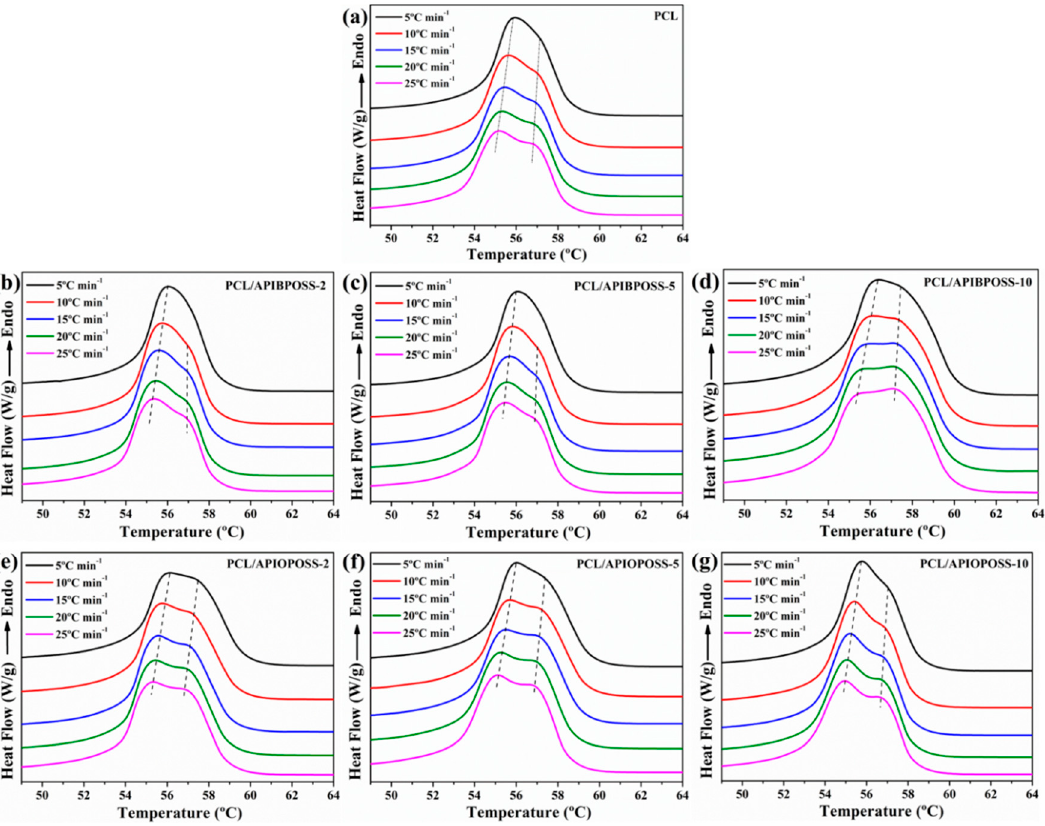
Figure 5. DSC thermograms of melting of ( a ) PCL, ( b – d ) PCL / APIBPOSS nanocomposites, and ( e – g ) PCL / APIOPOSS nanocomposites obtained during heating at 10 ◦ C min − 1 after non-isothermal crystallization at the indicated cooling rates.